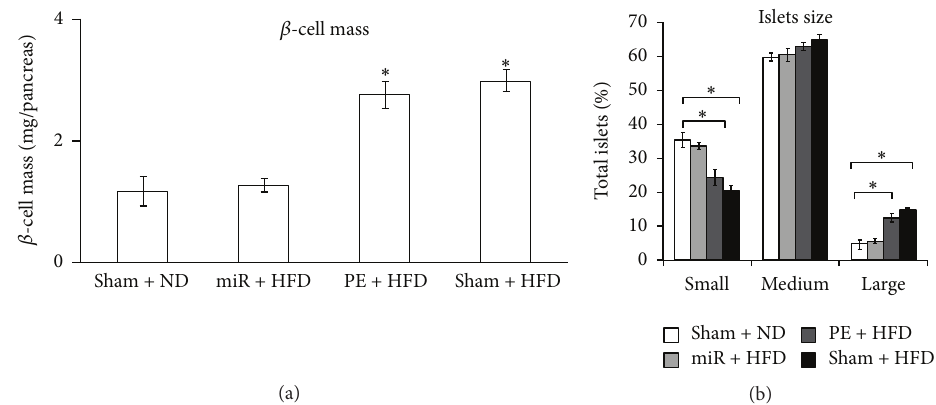
Figure 4: 𝛽 -cell mass and islets size. (a) 𝛽 -cell mass of animal at week 16. (b) Islets size of pancreas at week 16. All values are given as mean; error bar represents standard error. ∗ 𝑝 < 0.05 , compared with Sham + ND